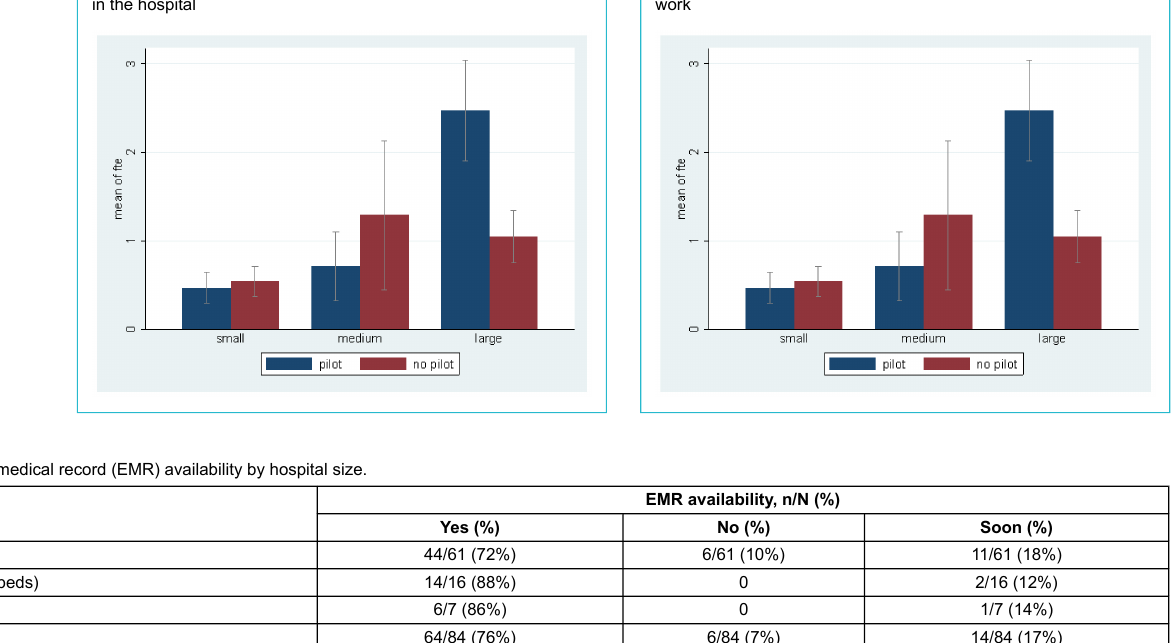
Figure 2: Fulltime equivalents (FTEs) dedicated to healthcare-as- sociated infection surveillance by hospital size, stratified by willing-